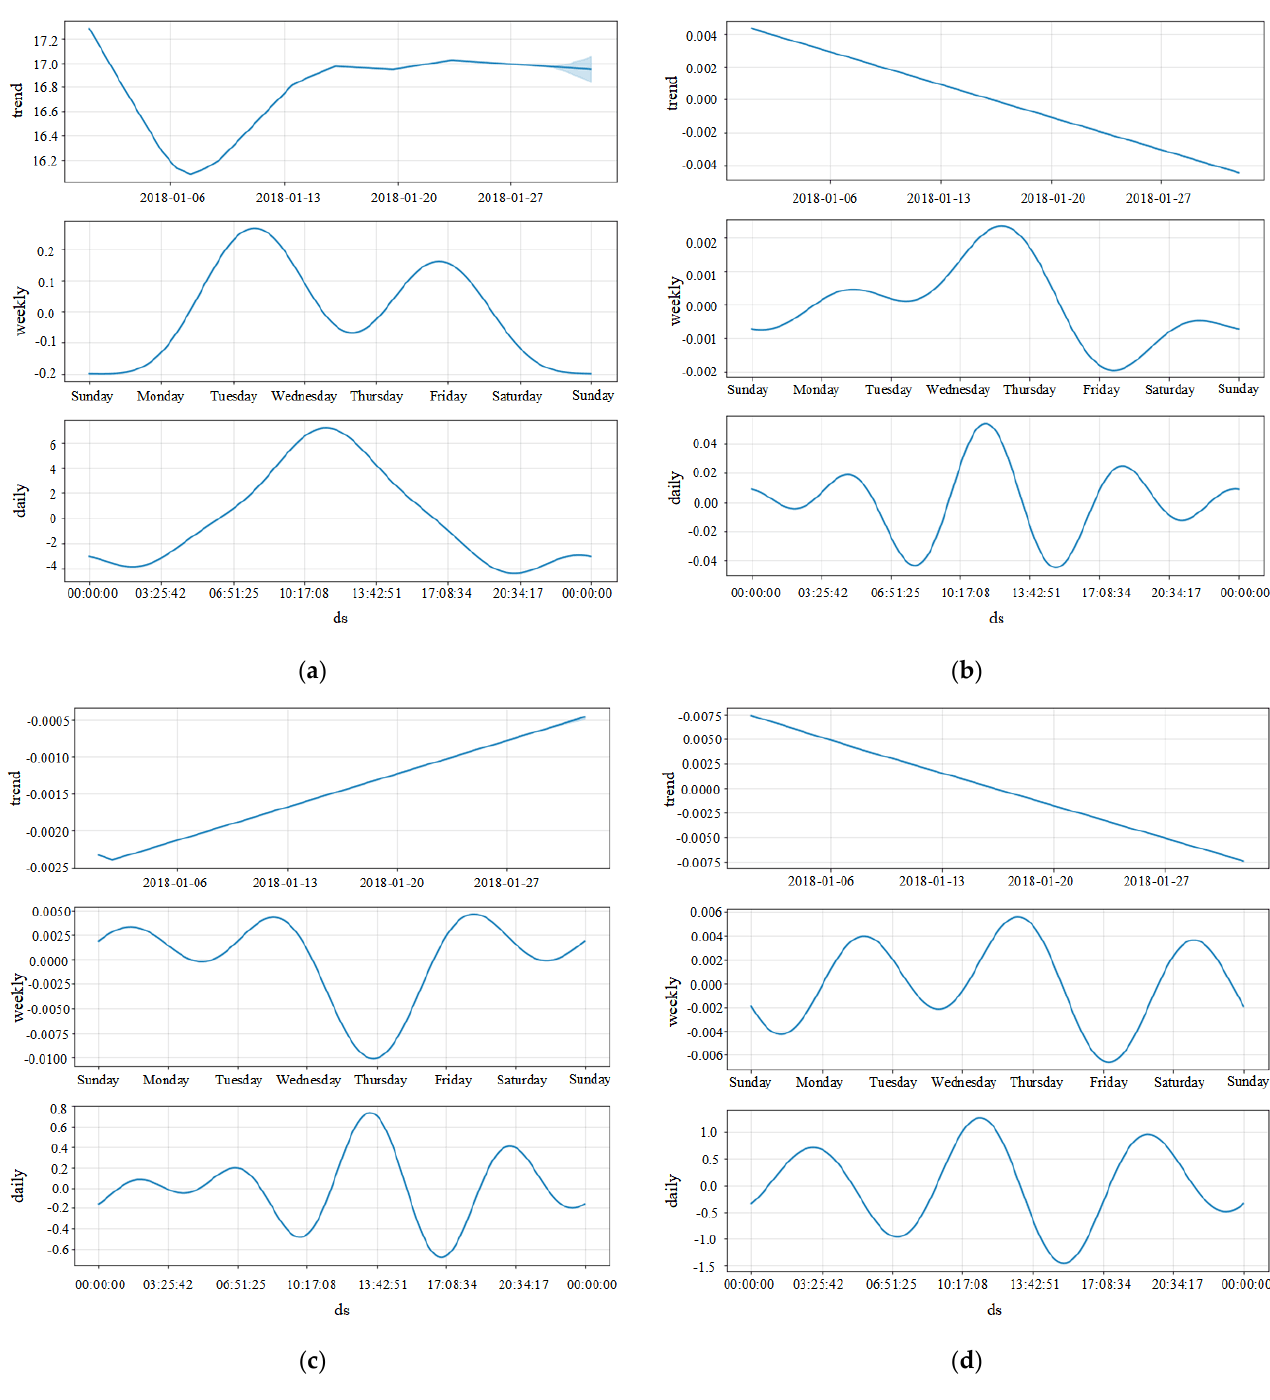
Figure 8. The trend term and periodic change in four components: ( a ) A 3 ; ( b ) D 3 ; ( c ) D 2 ; ( d ) D 1 .